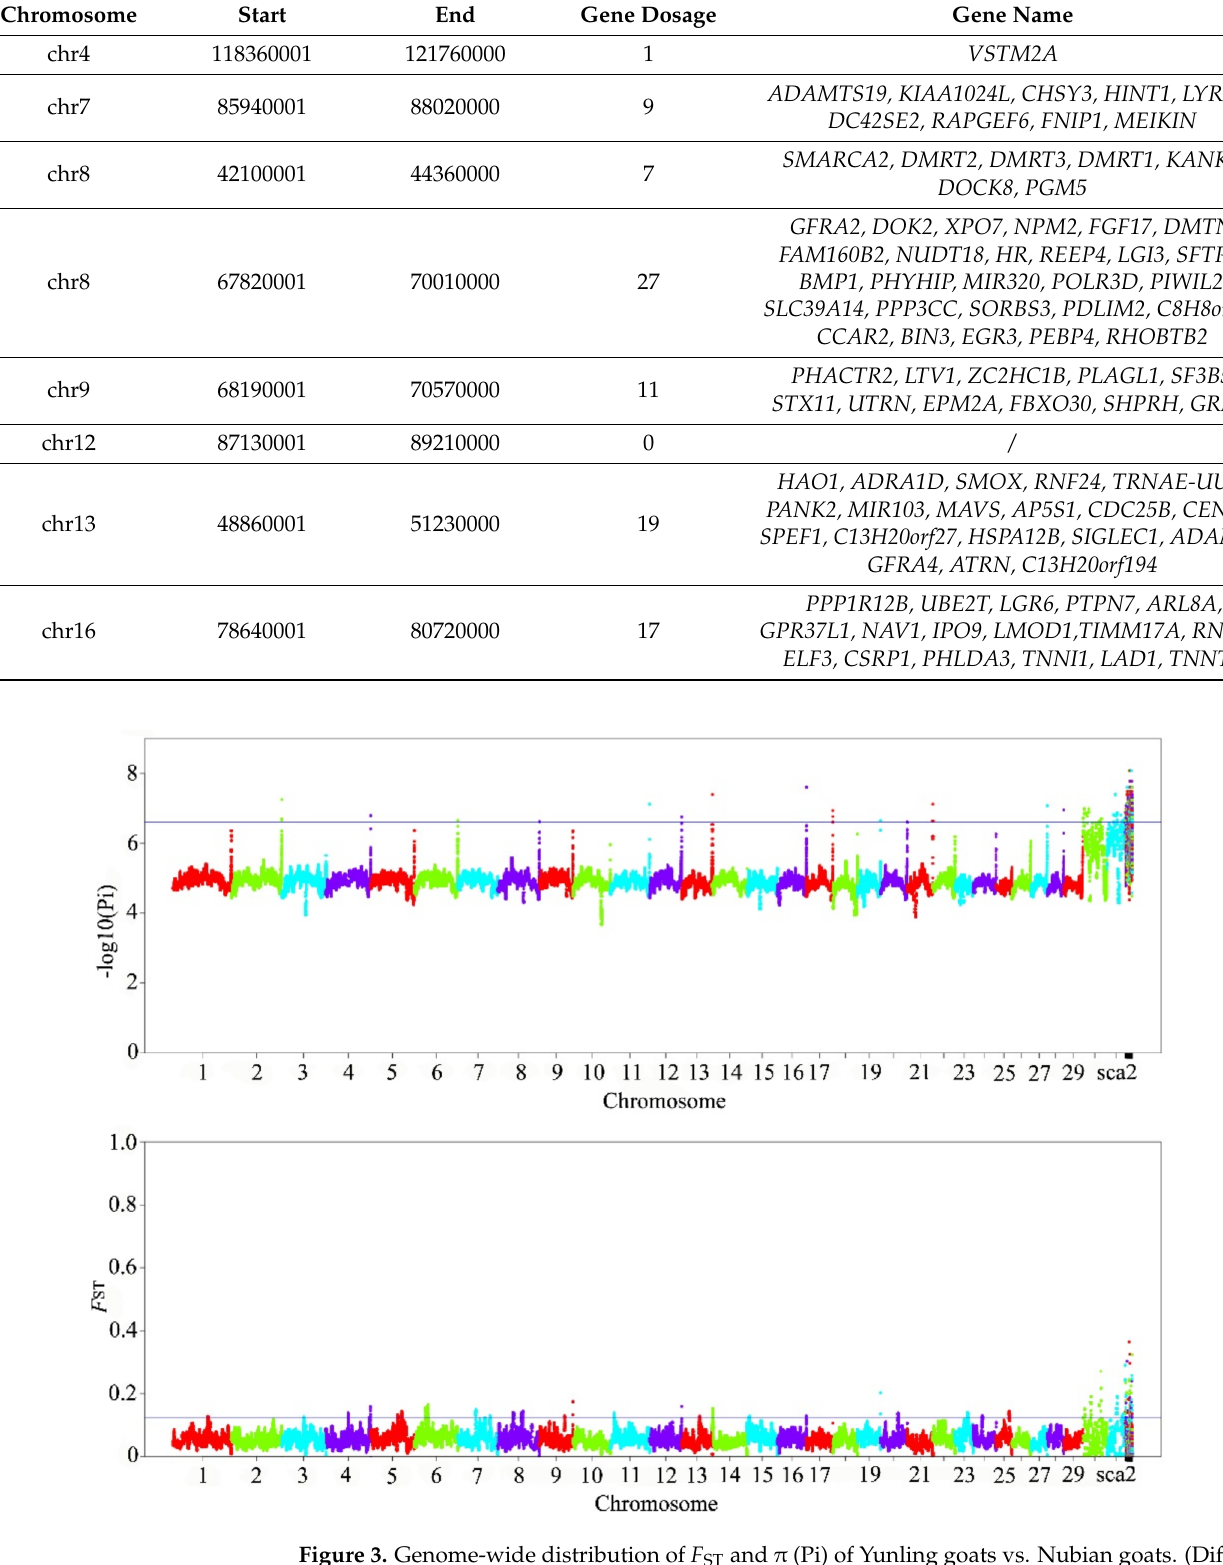
Figure 3. Genome-wide distribution of F ST and π (Pi) of Yunling goats vs. Nubian goats. (Different colors are used to distinguish the corresponding part of different